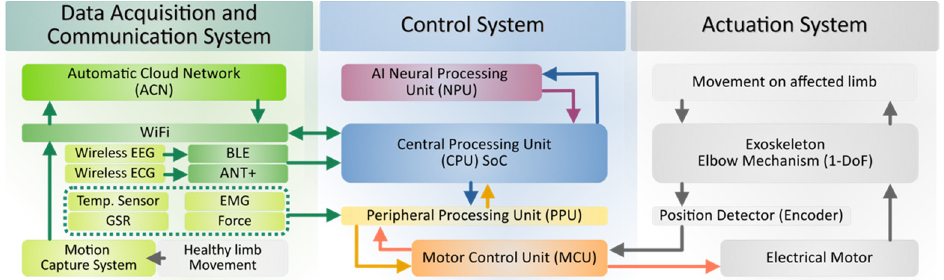
Figure 1. Overview diagram of the main subsystems that constitute the exoskeleton pro- totype.